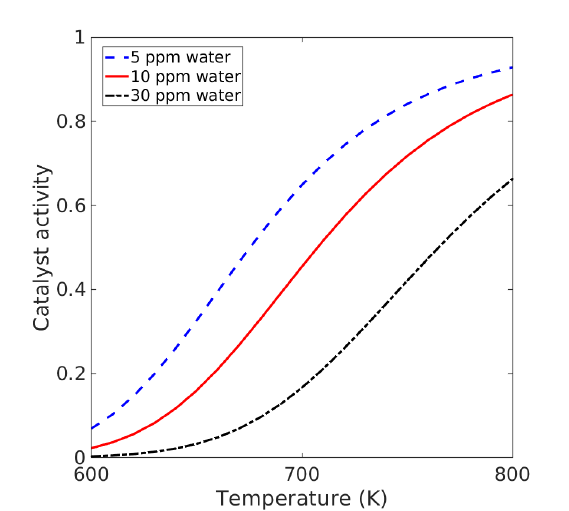
Figure 2. Catalyst activity as a function of temperature for different water concentrations in the gas mixture. P = 150 bar, H:N = 3, y Ar = 0.05, y NH